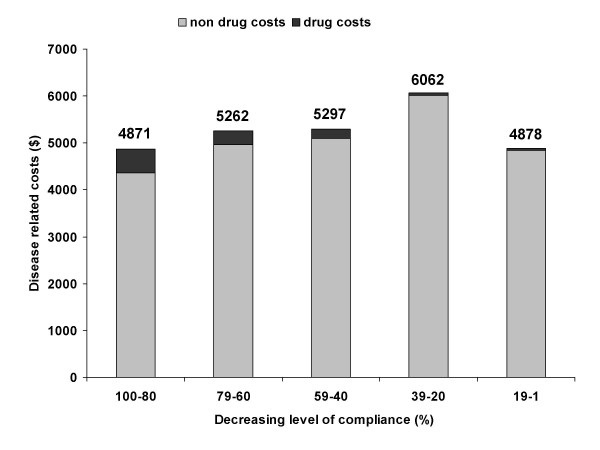
Disease-related healthcare costs in relation to the level of compliance for hypertension [24]. Costs are in $.